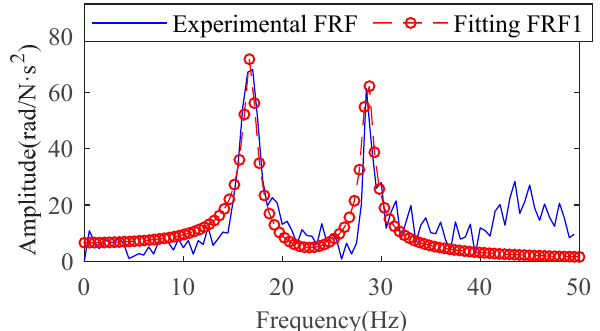
Figure 18. Two single-degree-of-freedom systems.